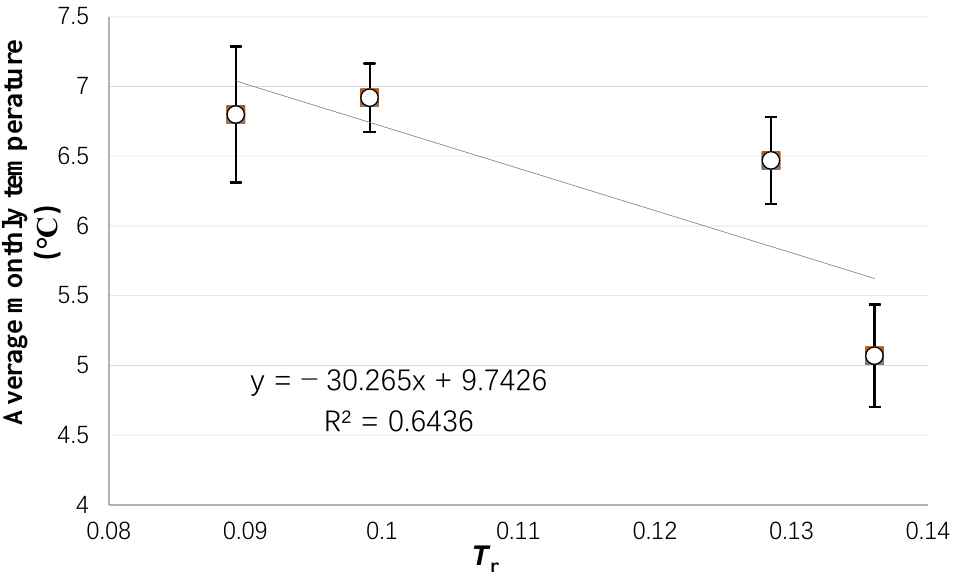
Figure 6. Relationship between T r and the average temperature of March from 2012 to 2015 (with the Standard Error of Mean on daily average temperature of each March).